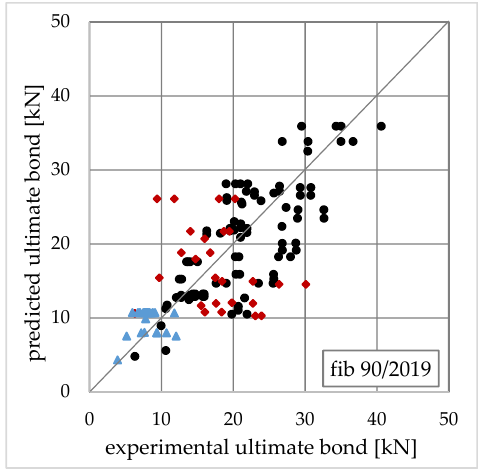
Figure 25. Test vs. predicted bond force using the fib 90/2019 model [38].